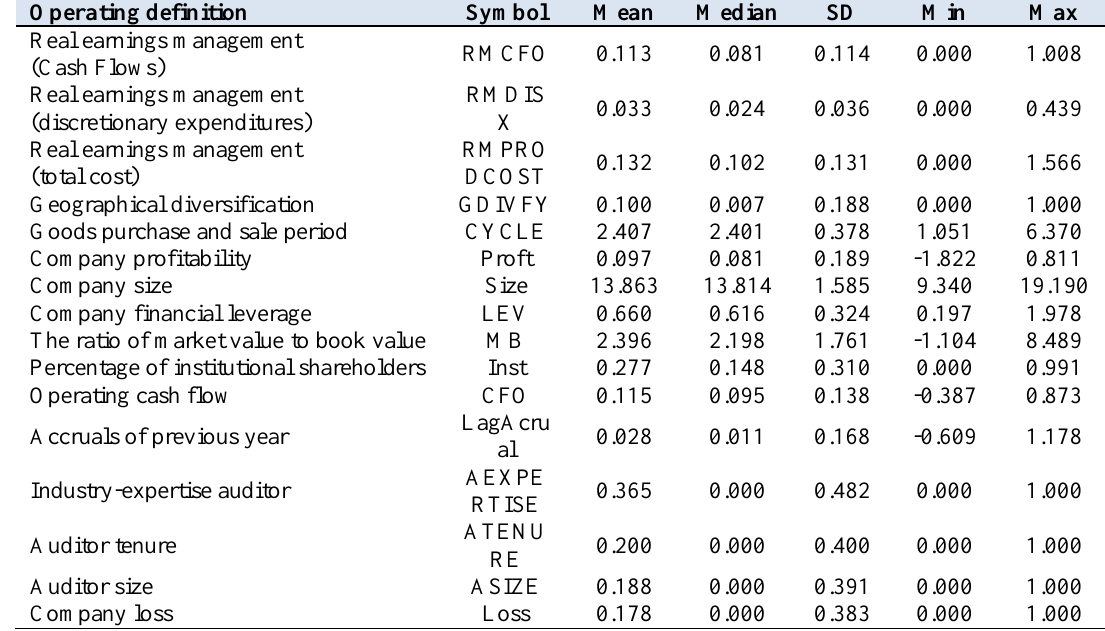
Table 2. The descriptive Statistics Indicators of Research Model Variables